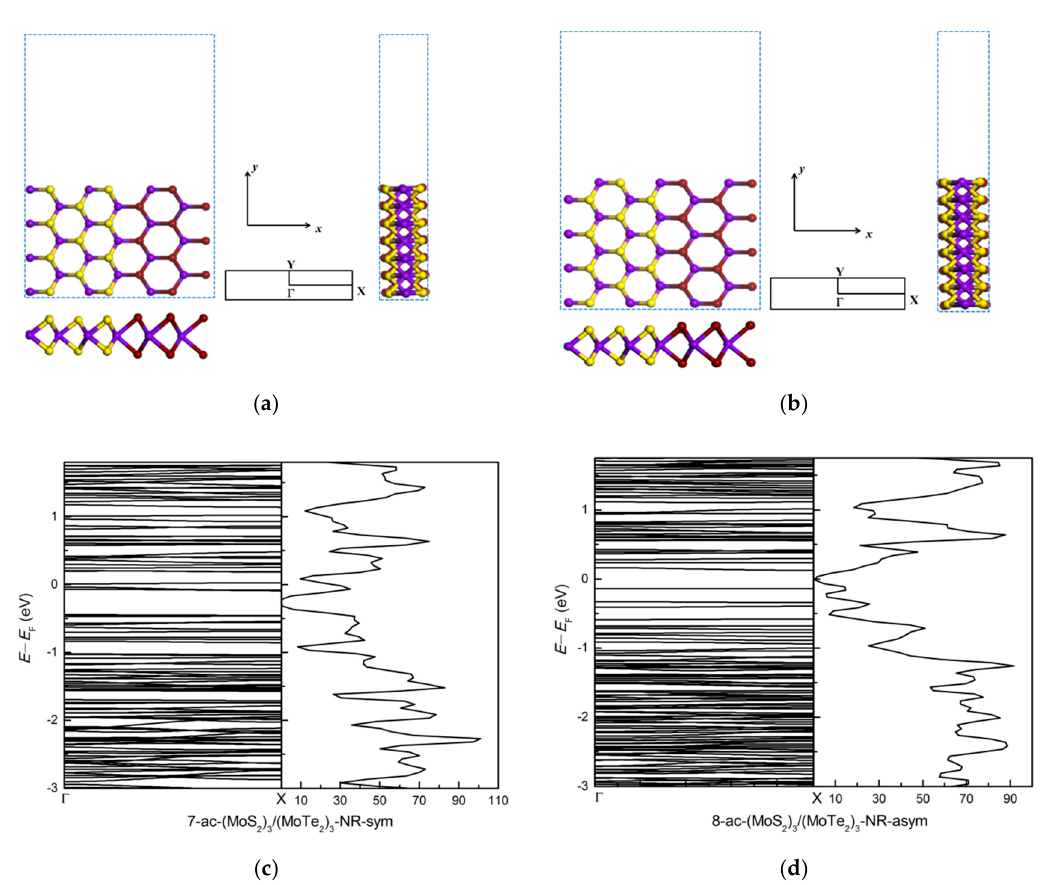
Figure 8. Top and side view of bare armchair (MoS 2 ) 3 /(MoTe 2 ) 3 nanoribbons: ( a ) 7-ac-(MoS 2 ) 3 /(MoTe 2 ) 3 -NR-sym, ( b ) 8-ac- (MoS 2 ) 3 /(MoTe 2 ) 3 -NR-asym. The blue dotted rectangular shows the unit cell of armchair nanoribbon with a vacuum region along the y axis in ( a , b ); ( c , d ) show the bands and dos of bare 7-ac-(MoS 2 ) 3 /(MoTe 2 ) 3 -NR-sym and 8-ac-(MoS 2 ) 3 /(MoTe 2 ) 3 - NR-asym armchair nanoribbon structures. Table 2. The vertical displacements δ W , δ S , δ Te and the tilt angles ω 1 (for Mo-S bond), ω 2 (for W-S bond), ω 3 (for Mo-Te bond) for symmetric, asymmetric (MoS 2 ) 3 /(WS 2 ) 3 and (MoS 2 ) 3 /(MoTe 2 ) 3 armchair nanoribbons. δ Mo − S , δ W − S and δ Mo − Te are defined